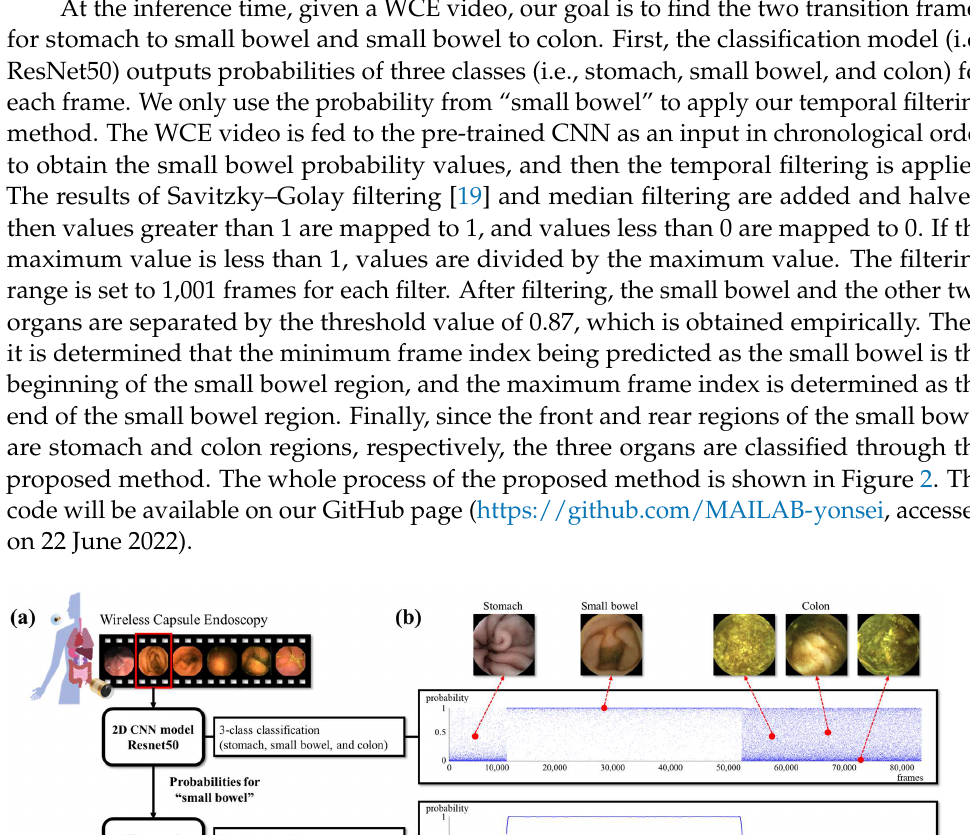
Figure 2. ( a ) The process of the proposed small bowel detection algorithm; ( b ) results from subpro- cesses with representative images from organs.